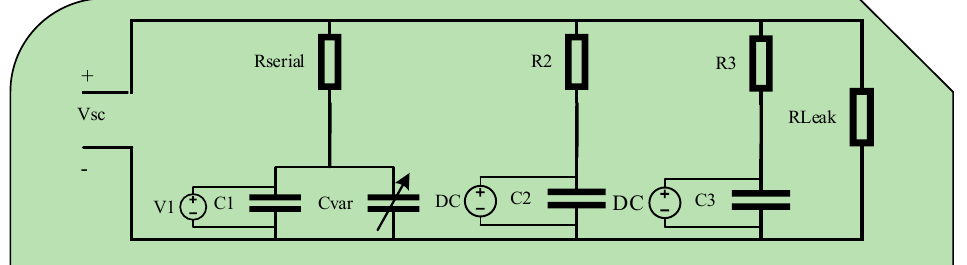
Figure 4. Three-branch ECM (TBECM) model for SOC estimation of